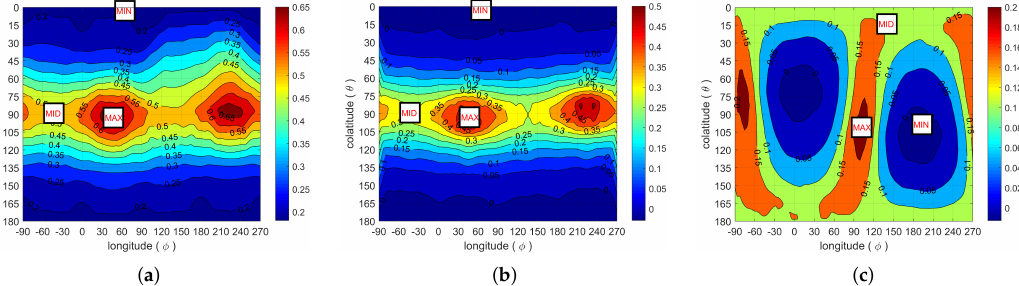
Figure 5. Spatial correlation R Z in [S1] at distances 8 ( a ) and 16 ( b ) voxels and in [S2] at a distance 16 ( c ). The labels MIN, MID and MAX indicate the eigendirections of the effective conductivity